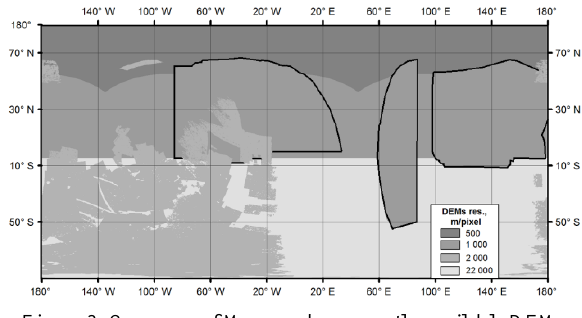
Figure 3. Coverage of Mercury by currently available DEMs Based on surface studies and newest results of stereo-processing of MESSENGER images obtained by MDIS (WAC and NAC) we are going to produce a new Mercury wall map to update the Terrestrial planets map series. Small interesting features of the Mercurian relief, for example, flat-floored craters and hollows, will be presented for selected study areas at large scale. In maps of global coverage, main relief features of the planet will be demonstrated.